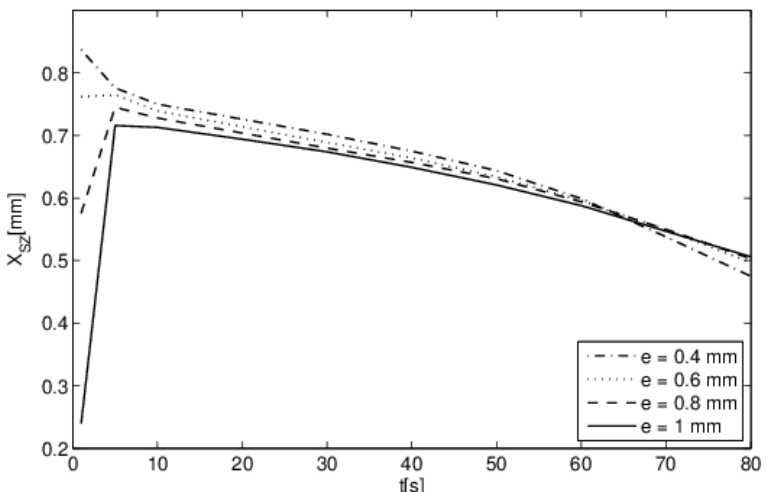
T h = 50 °C, Φ = 3 mW).